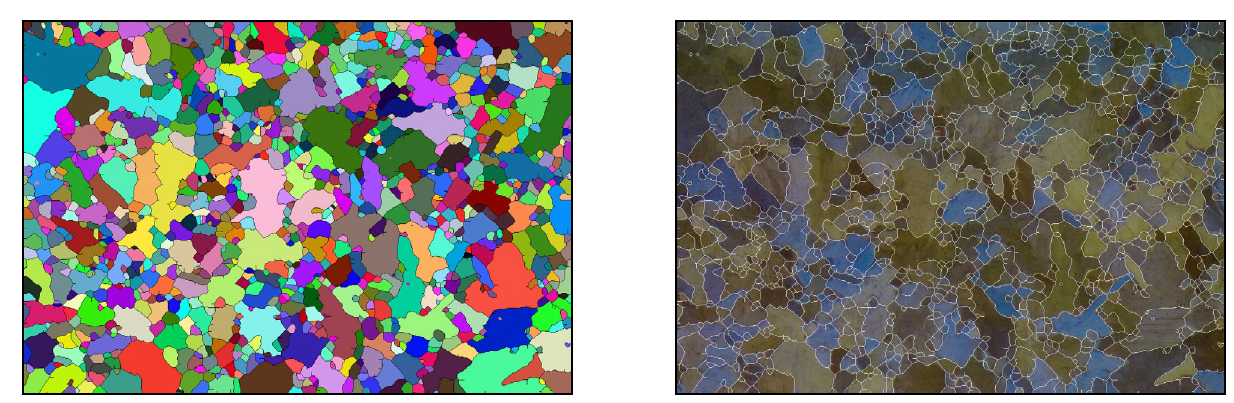
(c) Watershed contours after binarization. Figure 10. GB